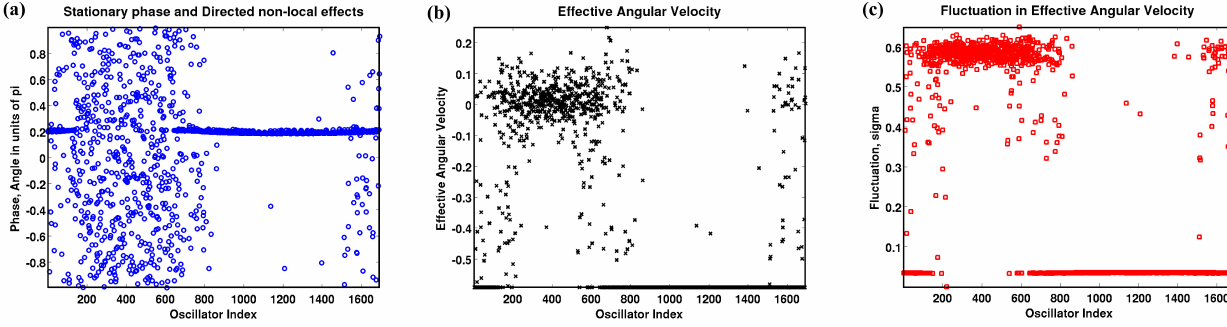
Figure 5. Three attributes of a chimera state of the 1693 oscillators for a 128 × 128 gridded map with recurrences using κ = 0.10. (a) Sta- tionary phase angle. (b) Effective angular velocity. (c) Fluctuations in instantaneous angular